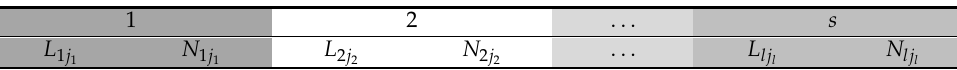
Table 2. Structure of a chromosome.